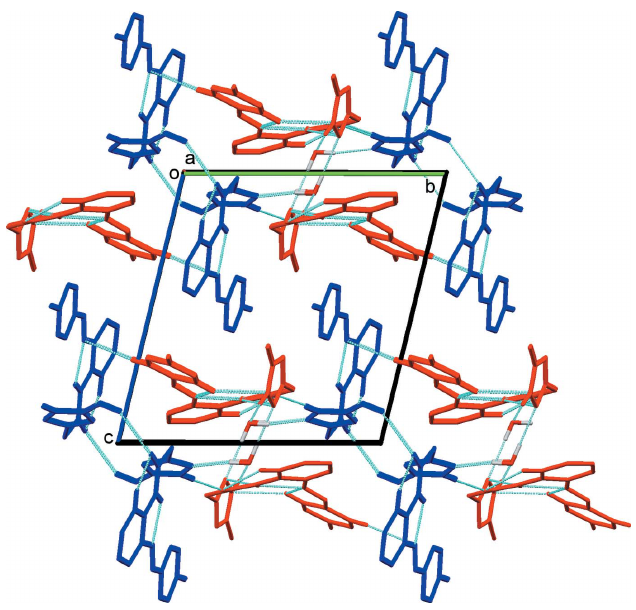
Figure 3 A partial view along the a axis of the crystal packing of the title compound. The hydrogen bonds are shown as dashed lines (see Table 1; colour code: molecule 1 is blue, molecule 2 is red).